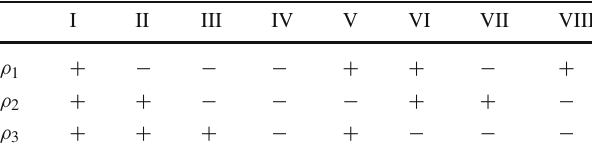
Table 1 The sign of phase factors for each Riemann